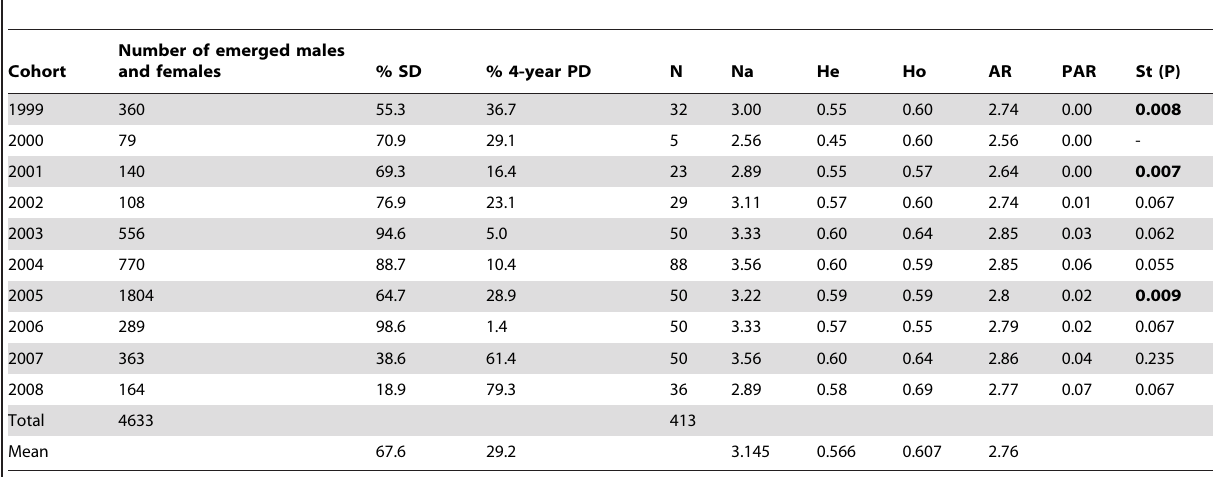
Table 2. Propensity to prolonged diapause and indices of population genetics of ten successive cohorts (1999–20008) in a natural invasive population of M. schimitscheki collected at Mont Ventoux, France.